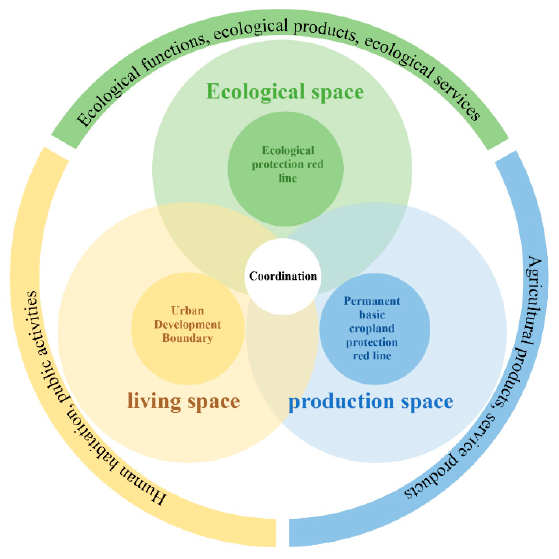
Figure 1. The relationship between the three spaces and control lines.